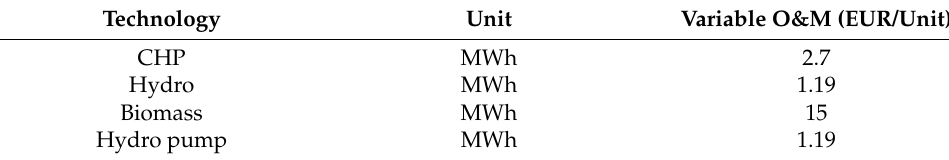
Table 3. Generating technologies considered variable O&M.